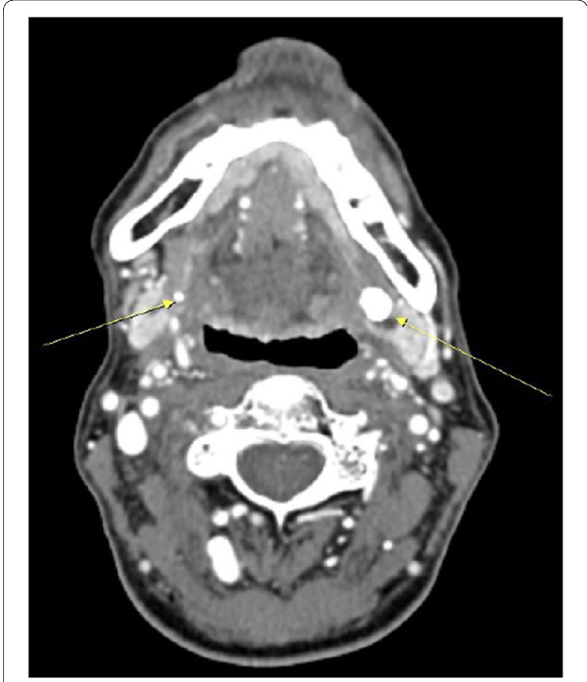
Fig. 1 Neck CT (enhanced) image with